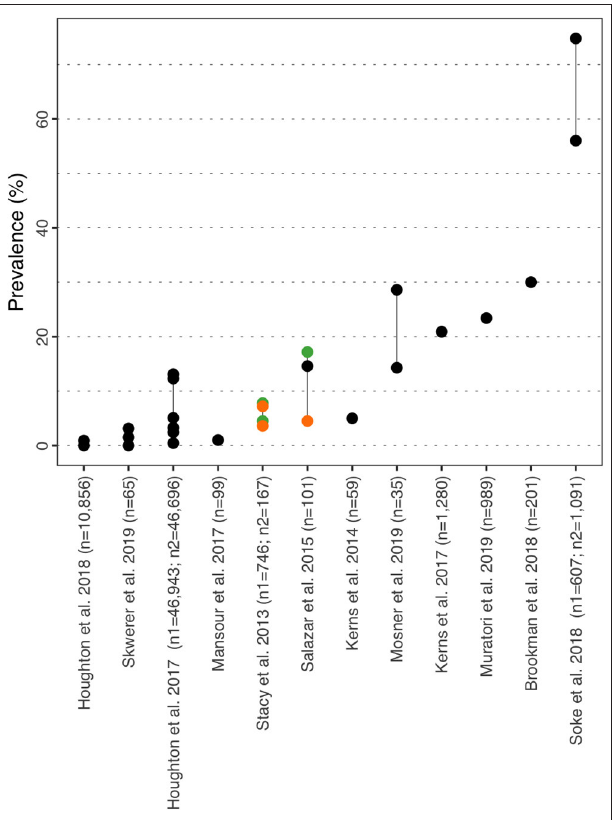
FIGURE 5 | Depressive disorders prevalence estimates. Each point reports a prevalence estimate for the related comorbidity. Studies with more than one data point indicate the estimate of the prevalence among different subgroup of the population. See Supplementary Table 4 for the description of the population used in each study. Sample sizes are shown in brackets above each study label. Orange mark: Female population only; Green mark: Male population only; Black mark: No sex